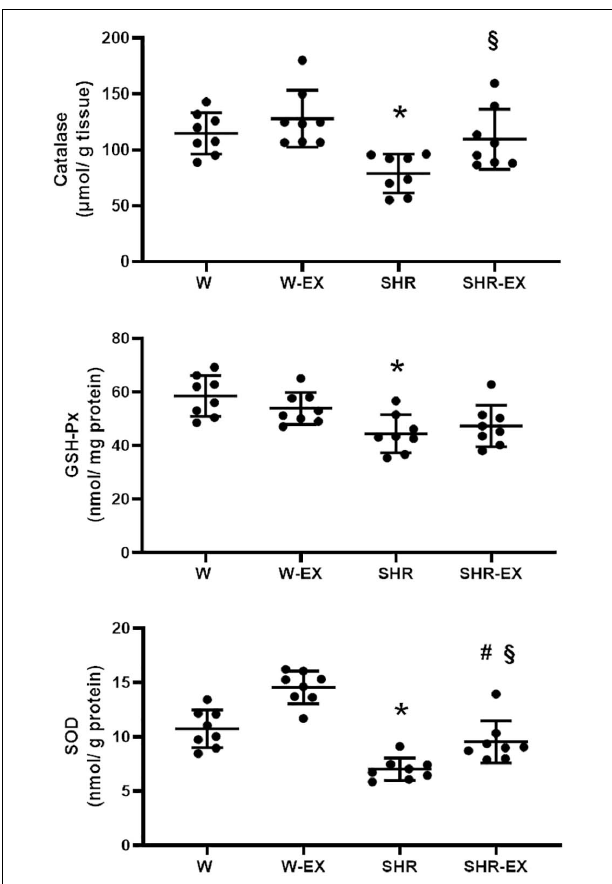
FIGURE 2 | Myocardial antioxidant enzyme activities. GSH-Px: glutathione peroxidase; SOD: superoxide dismutase. W, Wistar rats; W-EX, exercised Wistar rats; SHR, spontaneously hypertensive rats; SHR-EX, exercised SHR. ANOVA for a 2 × 2 factorial design and Tukey; * p < 0.05 vs. W; # p < 0.05 vs. W-EX, § p < 0.05 vs. SHR; n = 8 for all